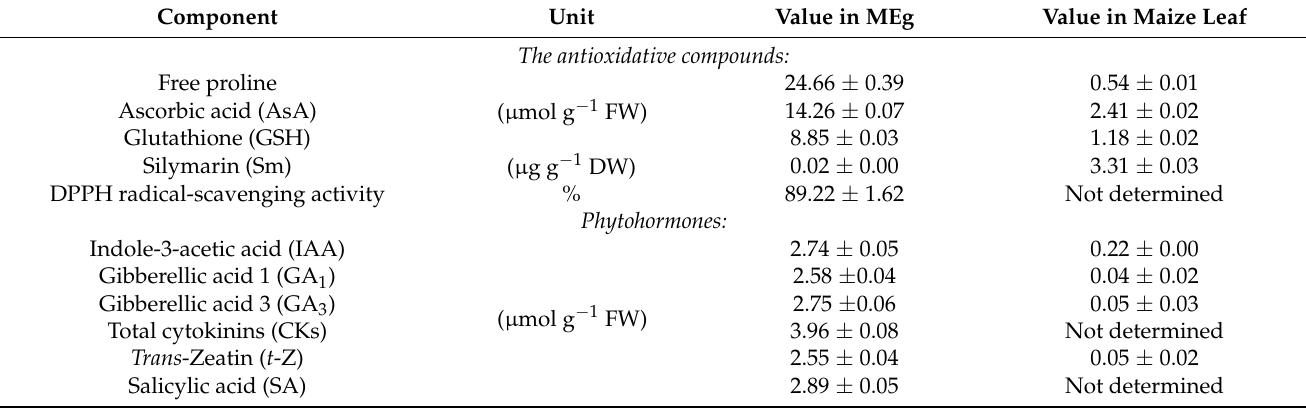
Table 5. Antioxidant and hormonal contents detected in maize grain extract (MEg) compared to their levels in maize leaves. Component Unit Value in MEg Value in Maize